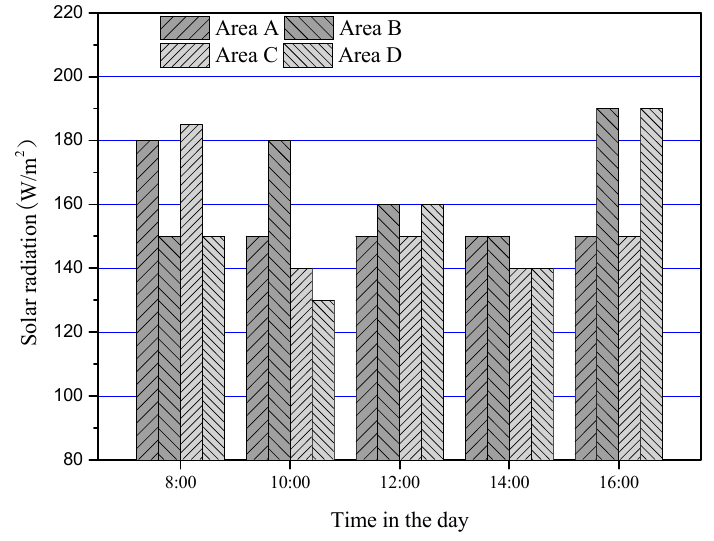
Figure 6. Average irradiance at the shadow area of each building.